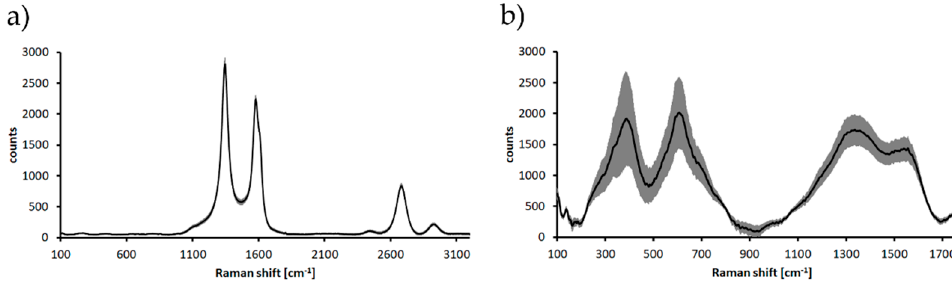
Figure 8. Raman spectra of ( a ) MR with MWCNTs coating (black line—average Raman spectrum; gray area–standard deviation of the signal); ( b ) TiC layer recorded for sample C2 (black line—average Raman spectrum; gray area—standard deviation of the signal).